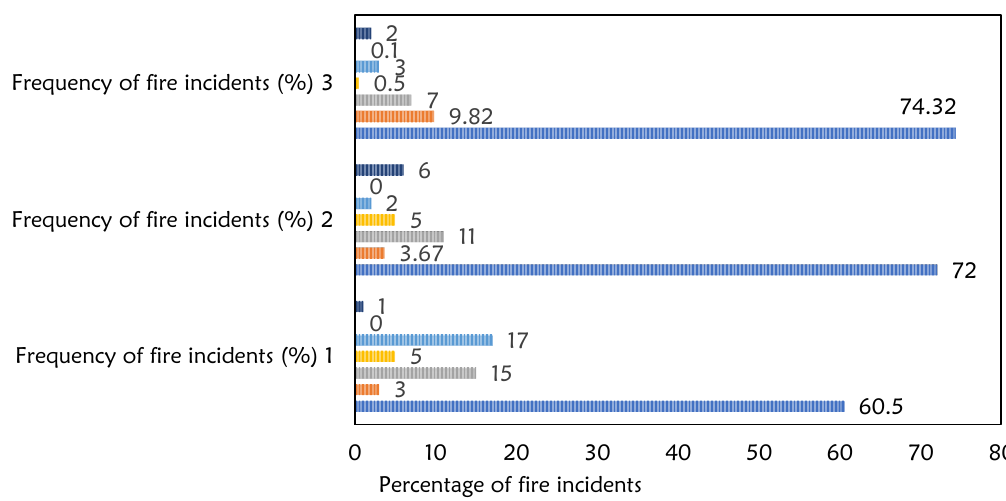
Figure 2: Distribution of sources of fire incidents according to structure type (2014)